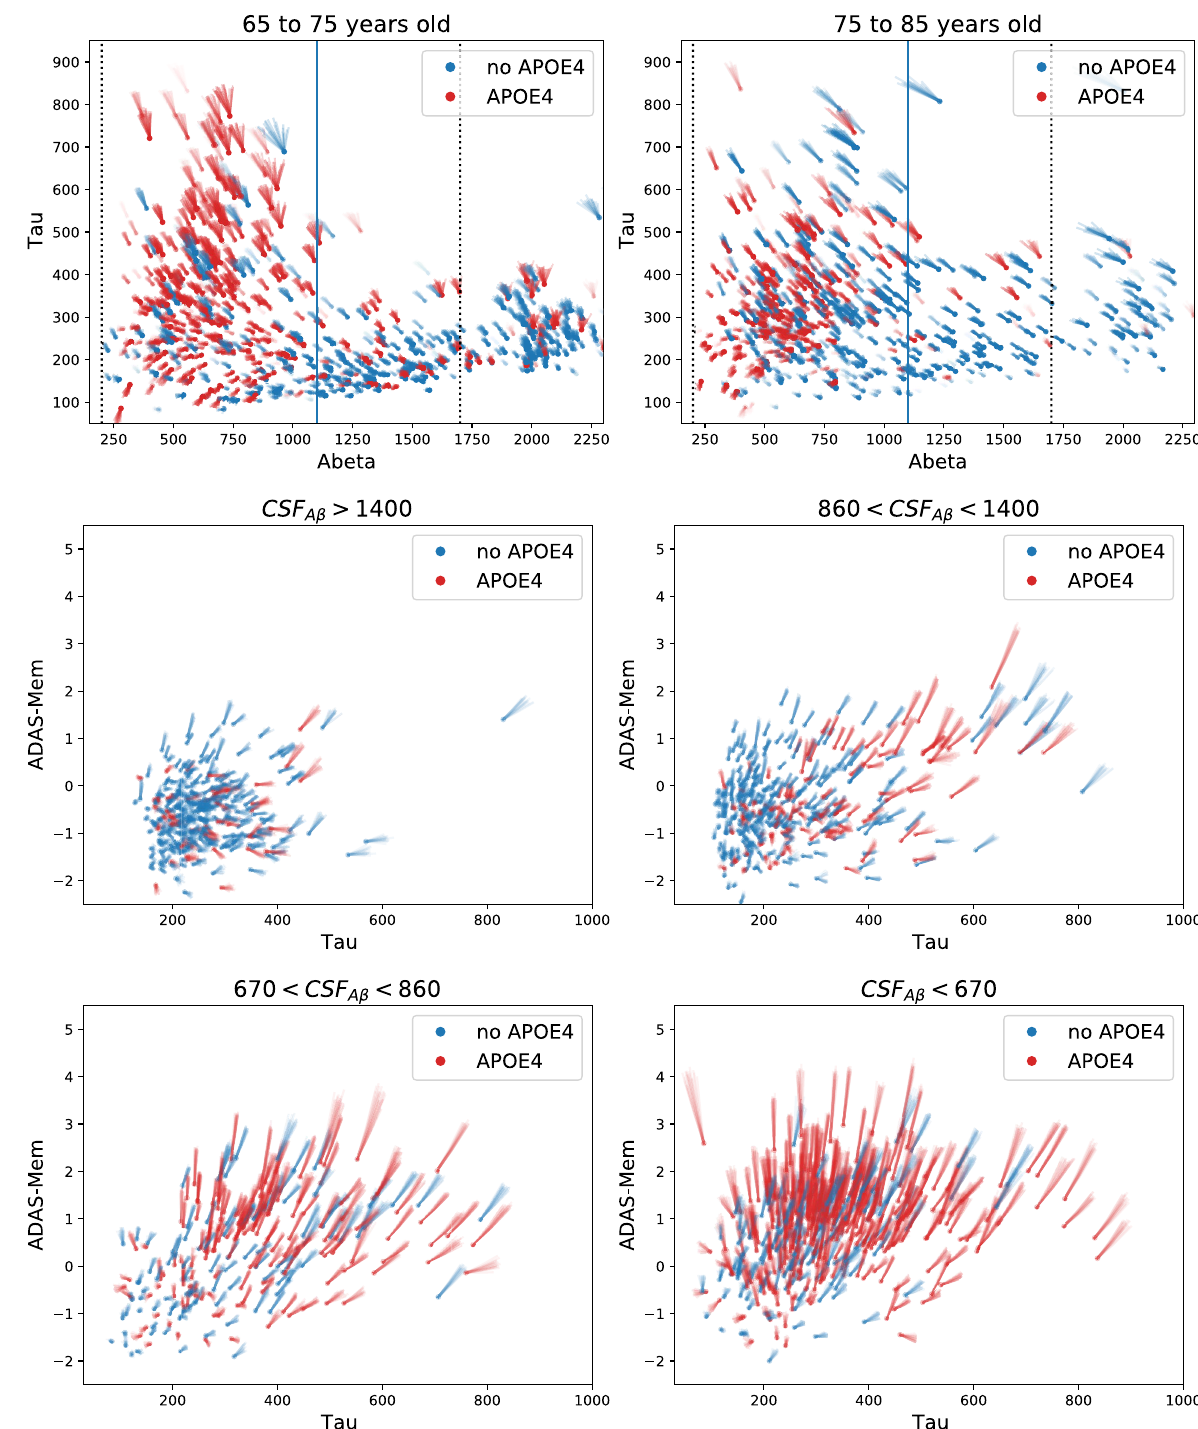
Figure 2. Velocity fields. Dots represent mean estimated initial values (i.e., basal level) and lines represent velocity (two years of evolution) and their uncertainty (lines are drawn from the posterior distribution). Top: CSF A β and Tau biomarkers. The left (right) panel shows younger (older) subjects. The solid vertical line at CSF A β = 1100 denotes the usual threshold of abnormality. Dotted vertical black lines show detection limits. A β values beyond these limits were estimated based on the censored likelihood, random effect components of the model, and consistency with the velocity field. The uncertainty of the initial A β value for these subjects (not represented in the figure) is much larger than for the rest. Middle and bottom: Memory trait of ADAS-Cog and CSF Tau for different levels of CSF A β . Larger ADAS-Mem denotes larger ADAS-Cog scores and, therefore, worse cognitive performance. Cut-offs for CSF A β (shown in the panel titles) corresponds to the 25% , 59% , and 75%